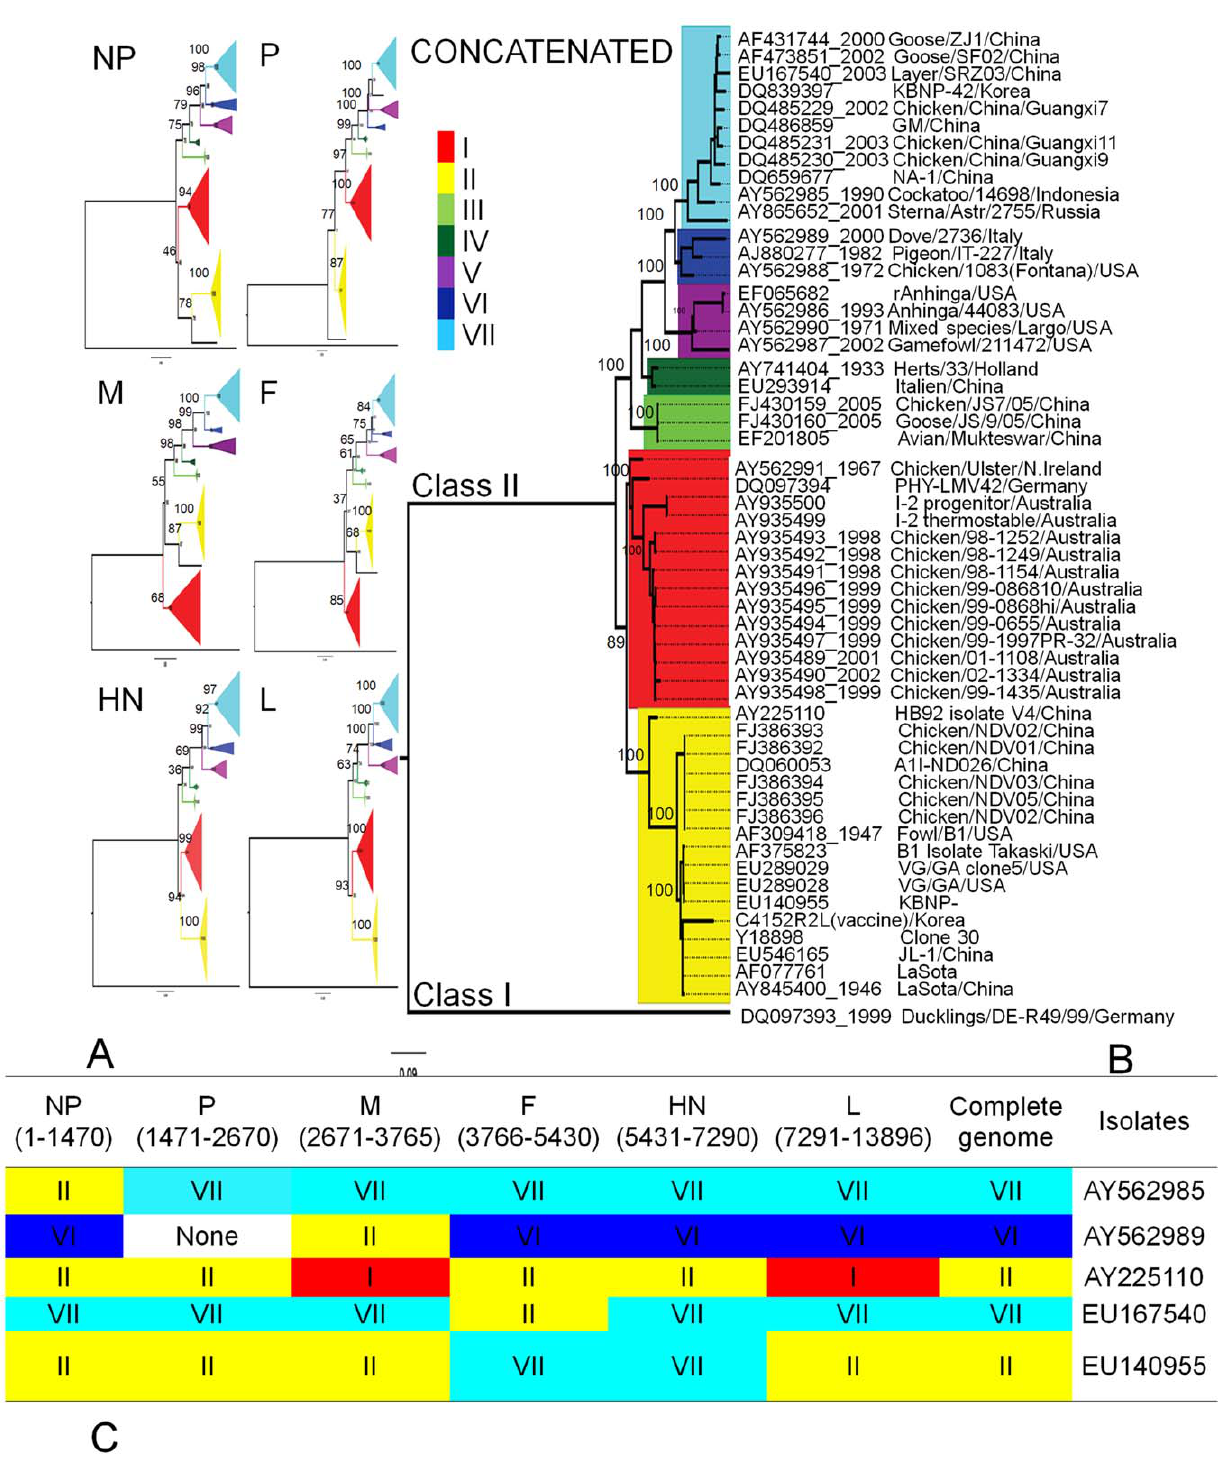
Figure 1. Maximum likelihood trees showing phylogenetic relationships among different genotypes. A total of 54 isolates representing seven different genotypes were used in the phylogenetic reconstruction. ( A ) Genotype topology based on each of the six aPMV-1 genes. Area of the triangle is proportional to the number of isolates within the genotype. ( B ) ML tree inferred from the concatenated gene sequences of the 54 isolates. Genbank accession number is shown for each isolate. Bootstrap supports are given at the base of the nodes. All trees are rooted with strain DQ097393, which belongs to class I aPMV-1. The trees are midpoint rooted for clarity. ( C ) Diagram of genotype affiliation of each gene for isolates that showed topological incongruence in different gene trees. Genotypes I, II, III, IV, V, VI, and VII, are coded with red, yellow, lime-green, dark-green, purple, cyan, and blue colors, respectively.